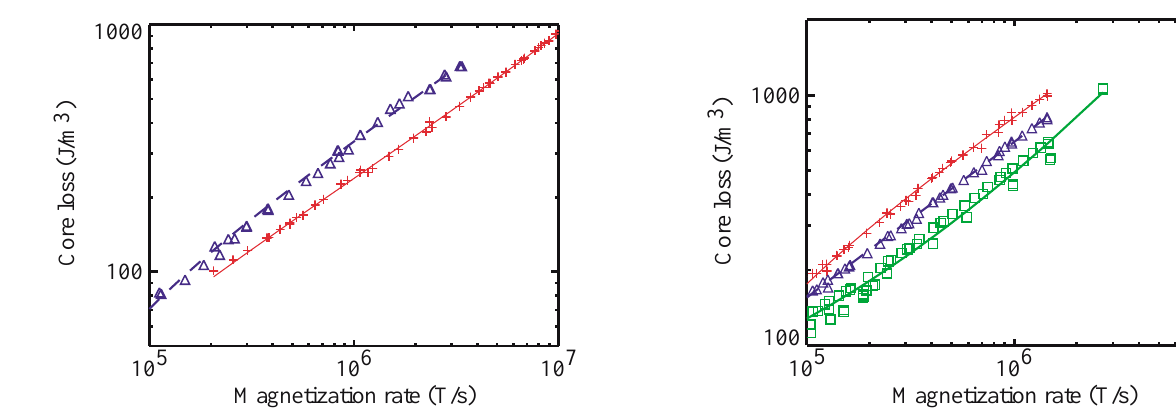
FIG. 11. (Color) Core loss versus magnetization rate for two METGLAS 2605 SC cores at 1.6 T flux swing: ( (cid:3) , blue, dashed line) annealed and rewound core Recirc-7 and ( 1 , red, solid line) Mica-C14.